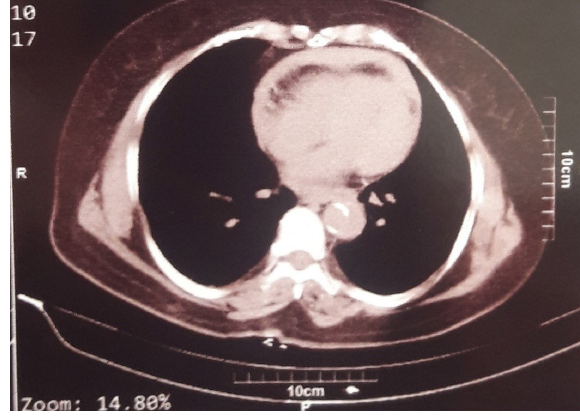
Figure 2. Crescent Sign in Non-contrast CT-Scan. Note . CT: Computed